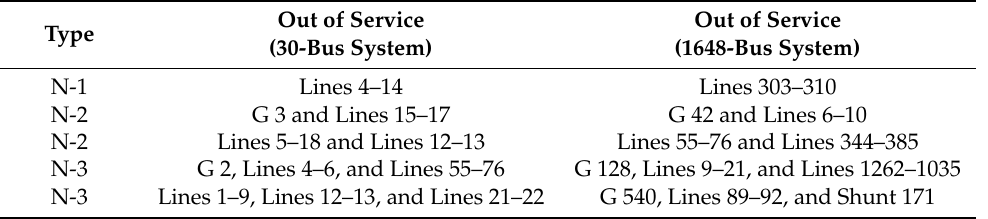
Table 3. Different network topologies for the two